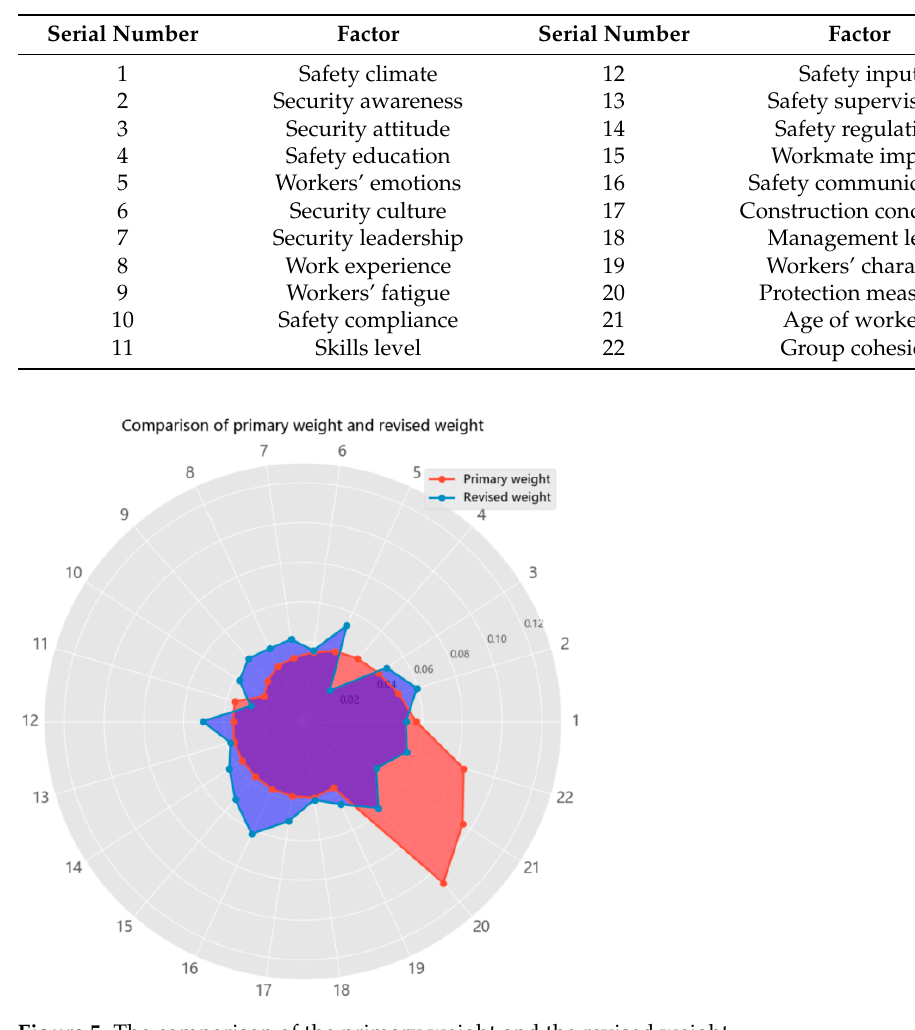
Table 14. The serial number of factors.